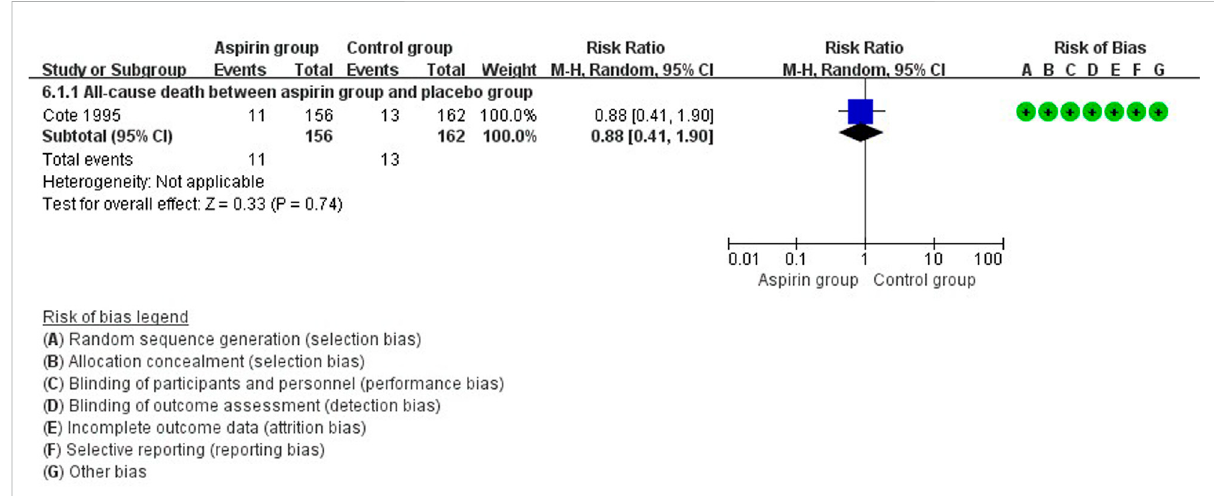
FIGURE 6 Forest plot of all-cause death between the aspirin group and the control group.